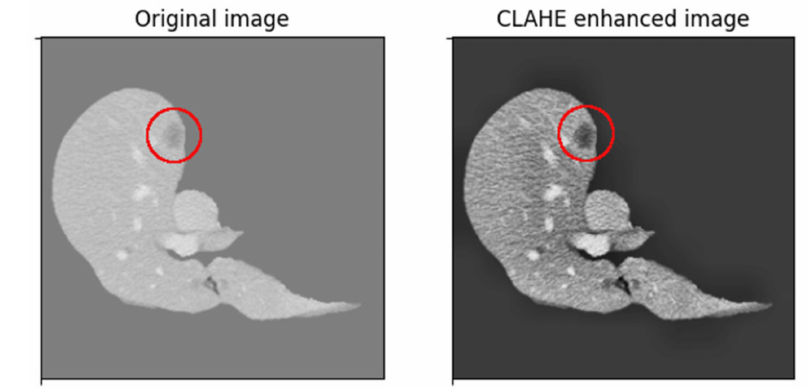
Figure 7. CLAHE increases lesion